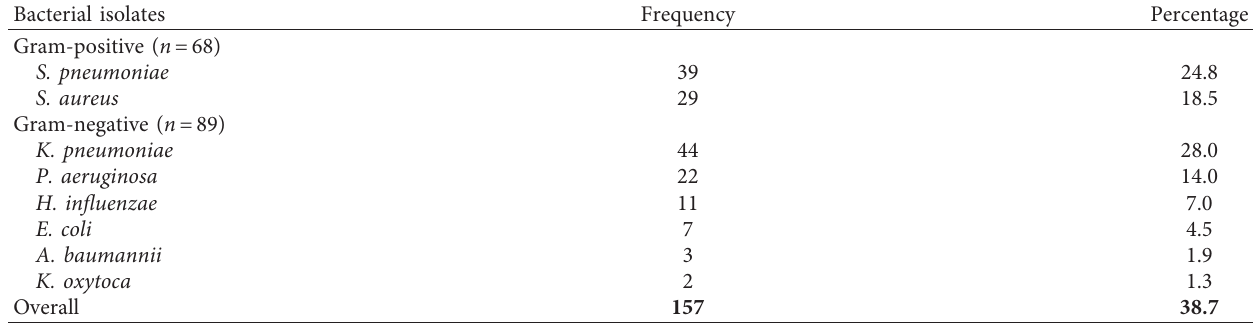
Table 2: The prevalence of bacterial isolates identified from pneumonia suspected patients, Dessie, 2020.